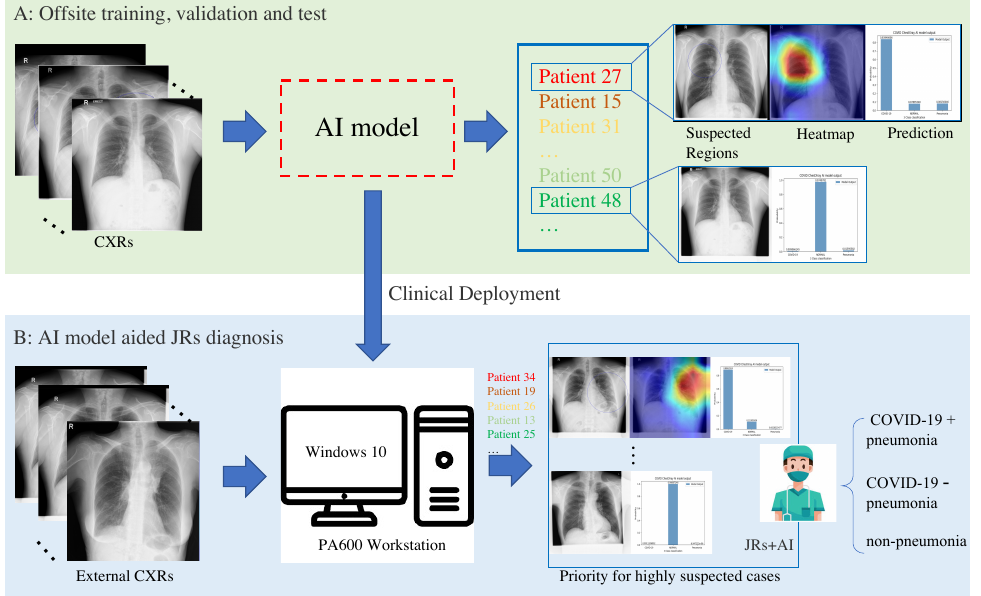
Figure 1. The workflow for training the AI model and conducting AI-aided diagnosis. Stage ( A ) involves training, validating, and testing the AI model for diagnosing CXRs. In Stage ( B ), the trained AI model is deployed in the hospital, and the junior residents (JRs) can upload CXRs to obtain the predictions and heatmaps generated by the AI model. By using AI results, the JRs can make more informed decisions.